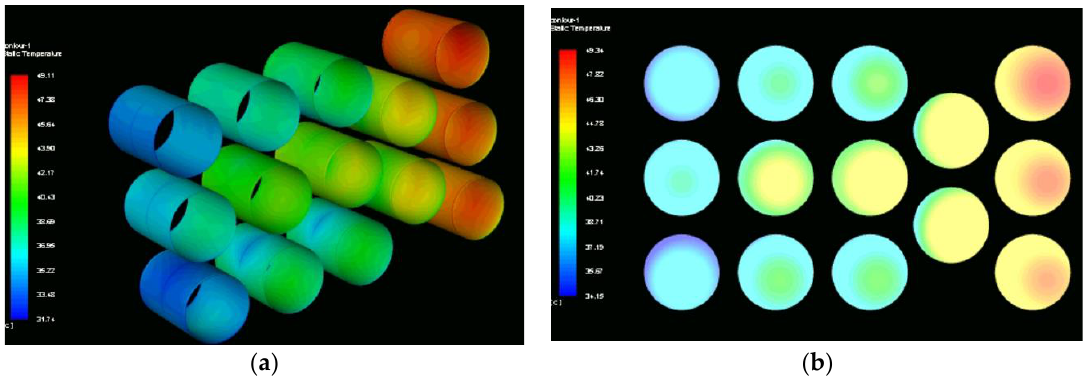
Figure 13. Temperature of the supercapacitors: ( a ) surface temperature; ( b ) through the middle section of the supercapacitors.